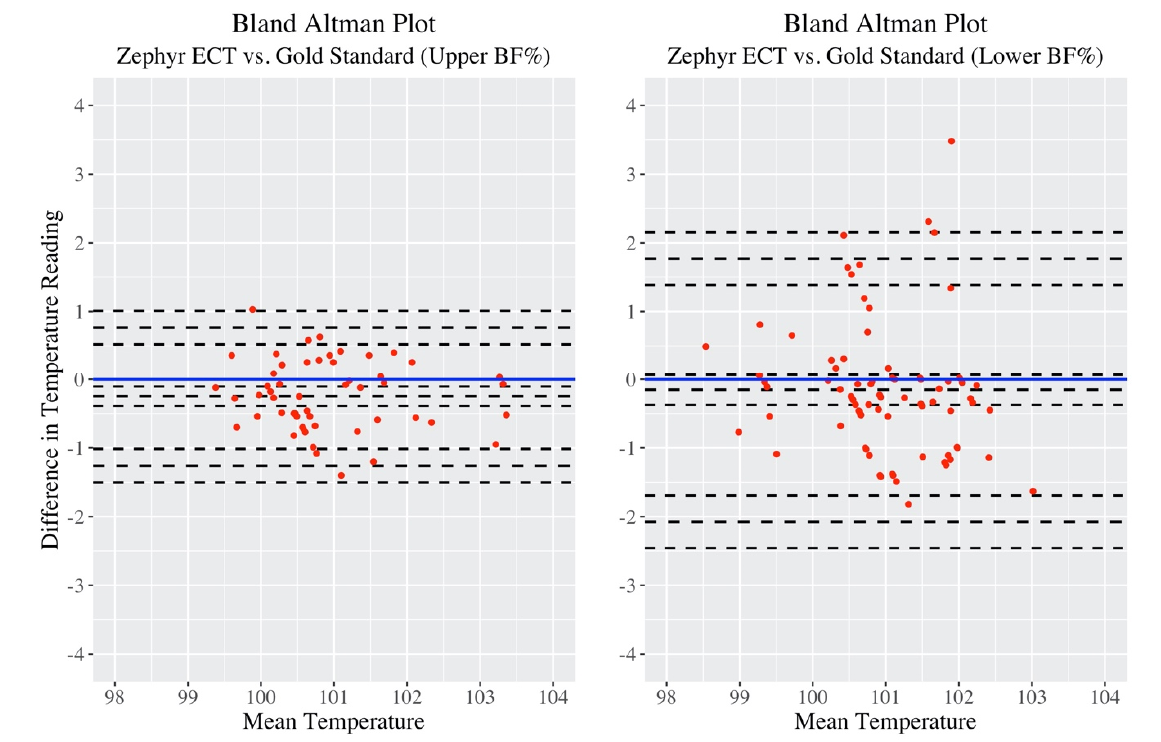
Figure 4. Side-by-side Bland–Altman plots for Upper BF% (left) group vs. Lower BF% (right) group.